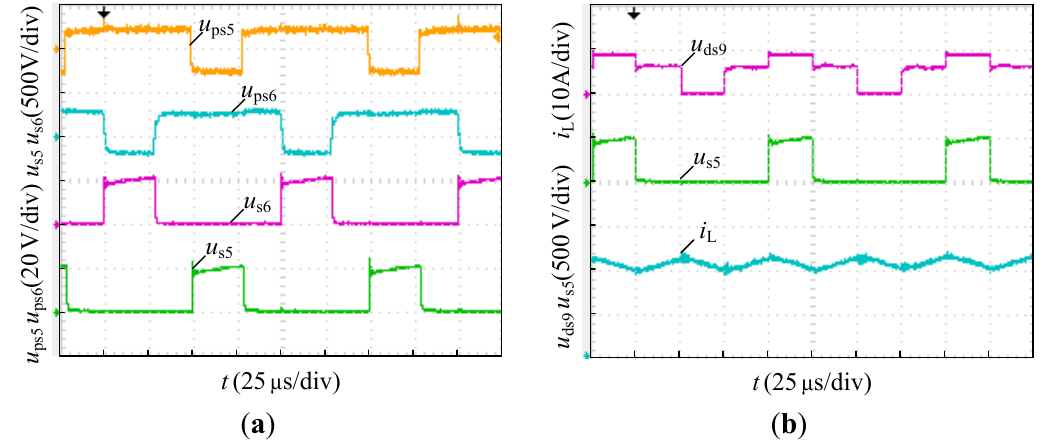
Figure 22. High-frequency operating waveforms of BSS-FBC in charging mode: , S ; ( b ) Voltage stress of the freewheeling diode ( a ) Driving pulse and voltage stress of S 5 6 of S , voltage stress of S , and inductor current. 9 5